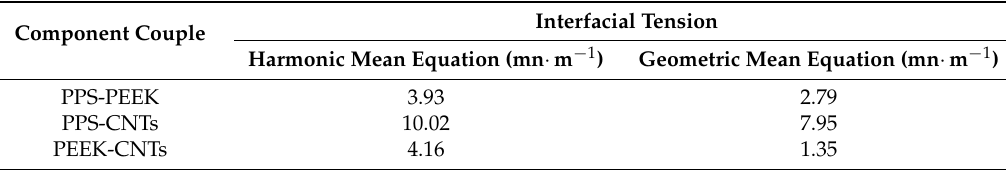
Table 3. Interfacial tensions as calculated using harmonic and geometric mean equations.